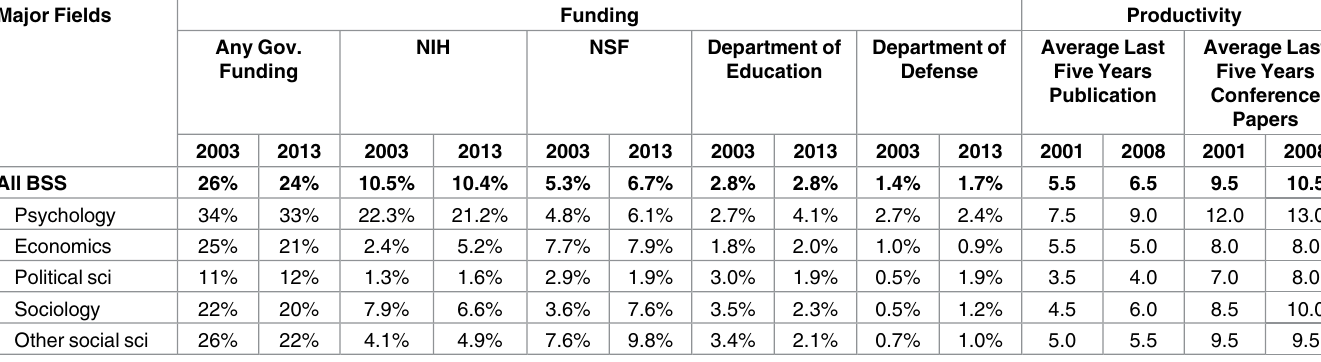
Table 5. Funding and productivity measures for BSSR.